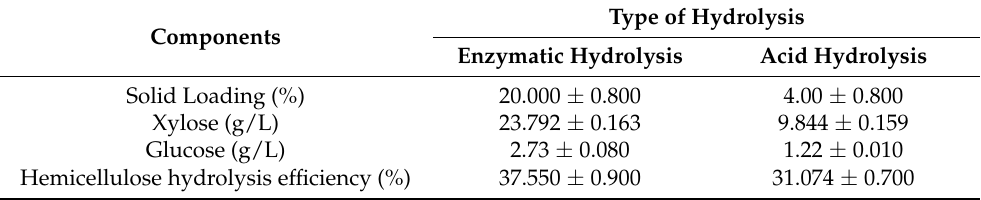
Table 2. Components of pineapple core